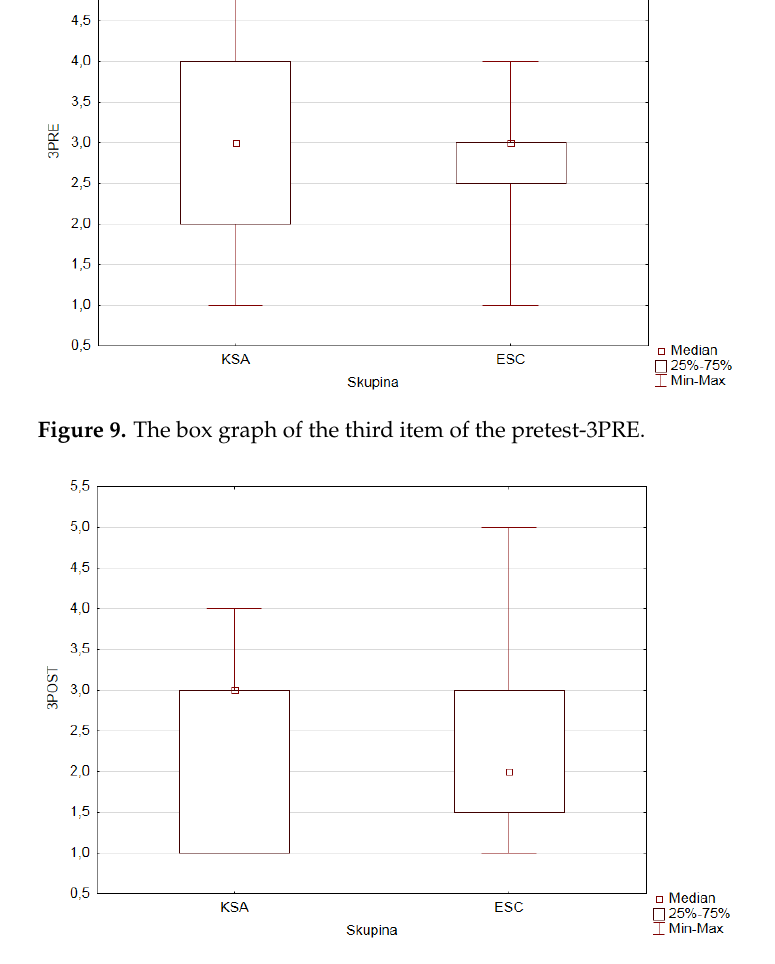
Figure 10. The box graph of the third item of the posttest - 3POST.